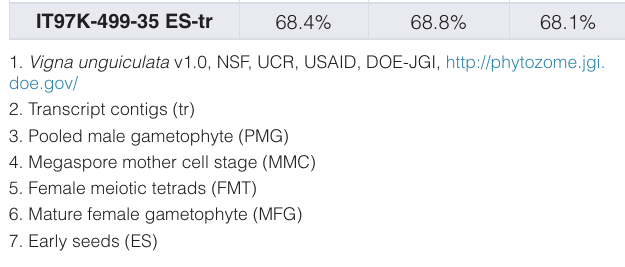
genomic contig size was 67 kb relative to median transcript contig size of 1.3 kb. This indicates that this resource contains substantial amounts of genomic sequence context around expressed genes in these tissues. This will be important for